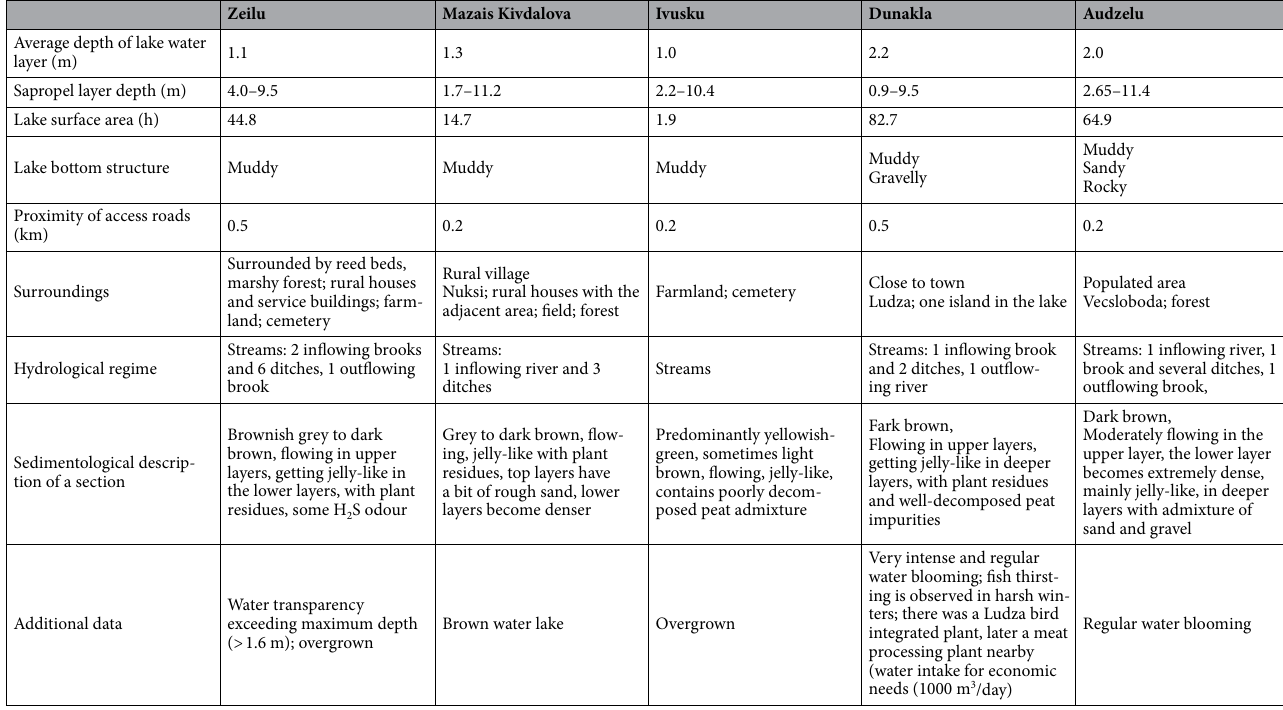
Table 1. Description of the